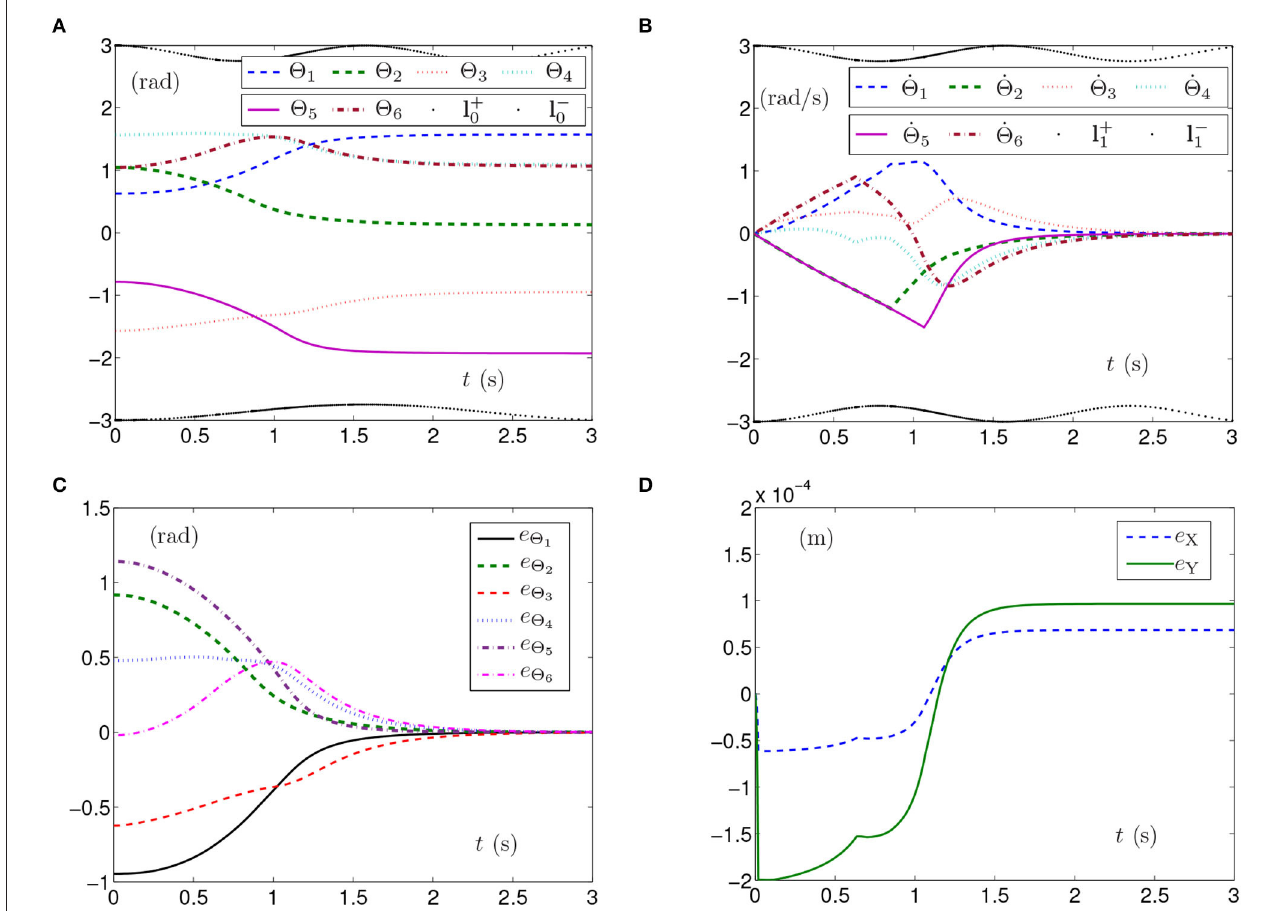
FIGURE 3 | Synthesized results of the planar manipulator using SMCS-2 with time-varying physical limits satisfied in case A. (A) Profiles of joint angles. (B) Profiles of joint-angle velocities. (C) Profiles of joint-angle errors. (D) Profiles of end-effector position errors.